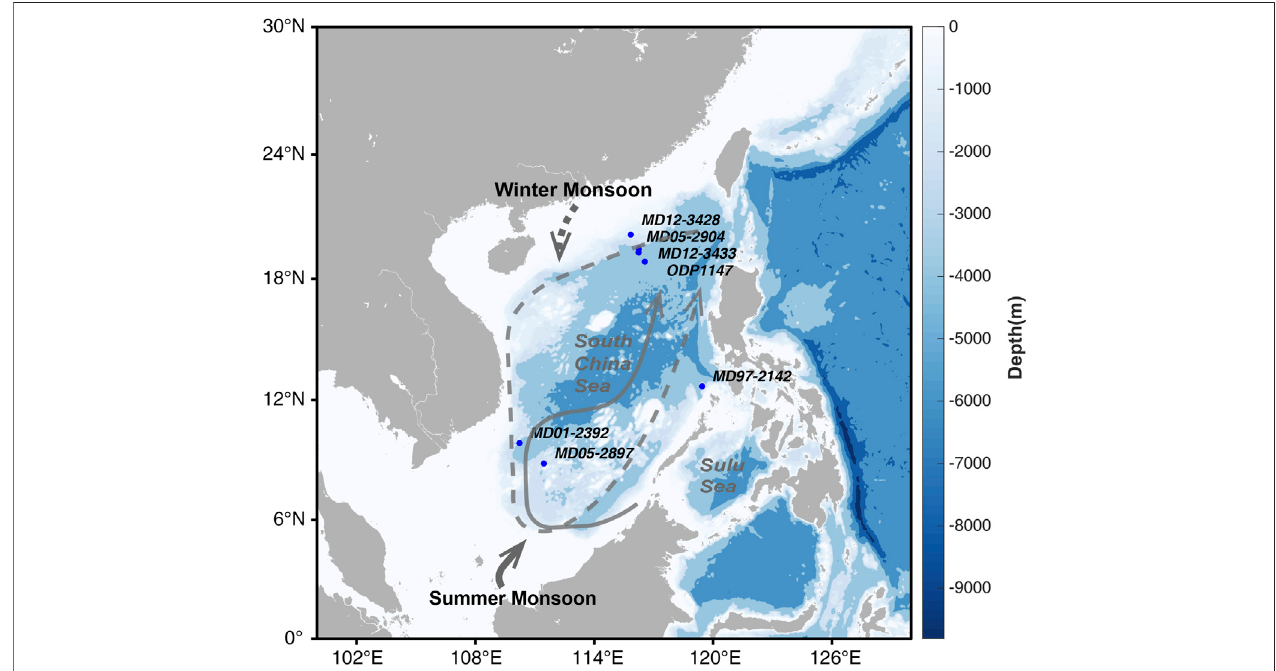
FIGURE 1 | Location of MD01-2392, MD05-2897, and MD97-2142 sites in the southern SCS and MD12-3428, ODP1147, MD12-3433, and MD01-2904 in the northern